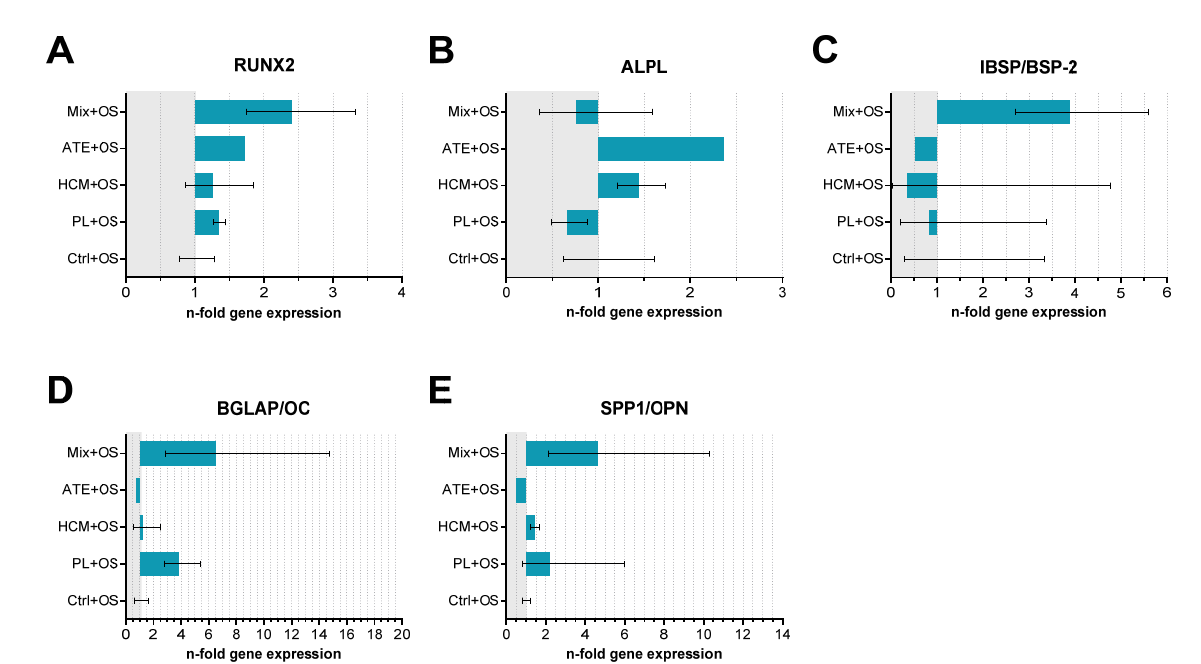
Figure 6. Relative gene expression ( n -fold of Ctrl+OS) of osteogenic markers ( A ) RUNX2, ( B ) ALPL, ( C ) IBSP/BSP-2, ( D ) BGLAP/OC and ( E ) SPP1/OPN in hBM-MSC cultured with osteogenic supplements in cell culture medium for 21 days on functionalized mineralized collagen scaffolds. Cell-seeded scaffolds without bioactive factor mixture functionalization served as control (Ctrl+OS; mean ± upper and lower limits, n = 2).